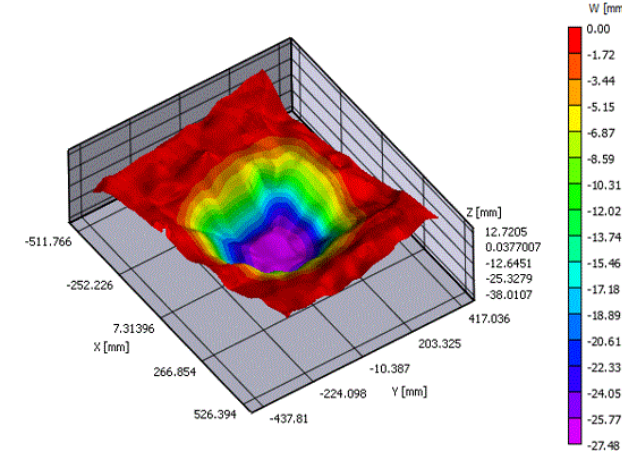
Figure 2. 3D soil vertical displacements W after cavity opening.